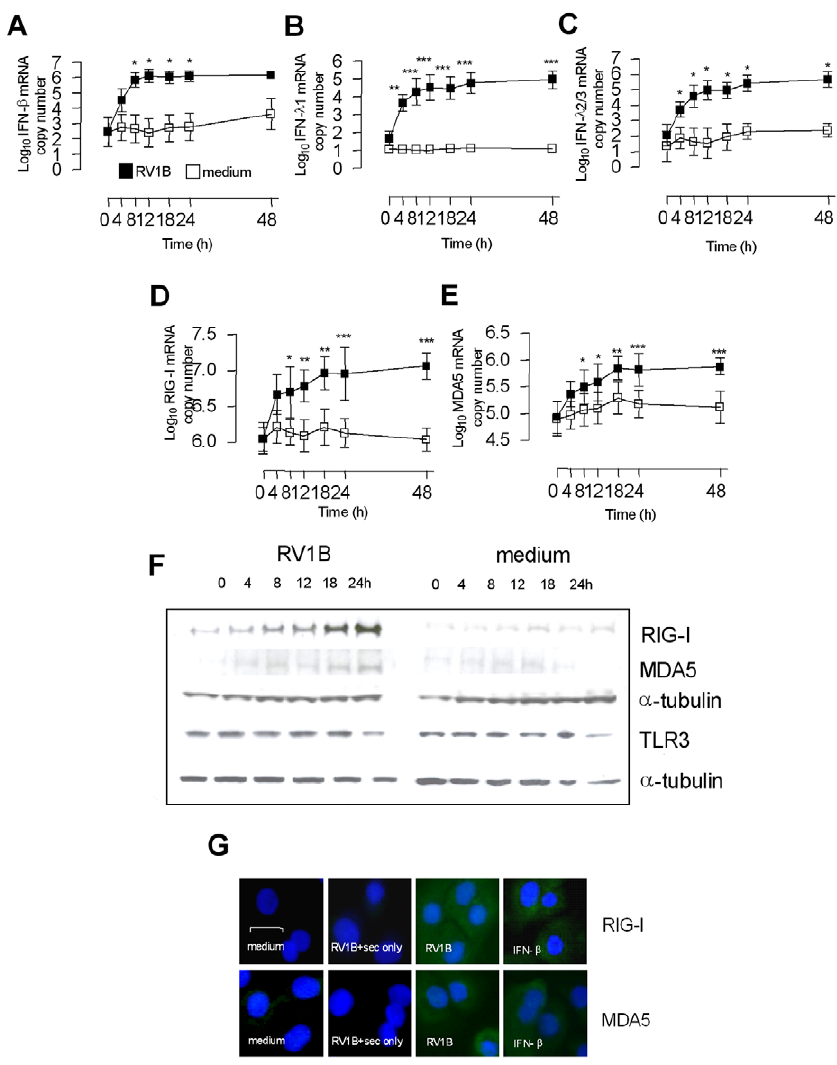
Figure 1. Kinetics of RV1B induced IFN- b , IFN- l s, RIG-I and MDA5 mRNA and protein expression in HBECs. HBECs were infected with RV1B or treated with medium and RNA and protein analysed over time. RV1B induced IFN- b (A), IFN- l 1 (B) and IFN- l 2/3 mRNA (C) in a time dependent manner, visible by 4 h, and peaking at 12–48 h. RV1B infection also induced RIG-I (D) and MDA5 mRNA (E), in a time dependent manner, peaking at 18–48 h. RV1B infection also induced RIG-I and MDA5 protein (F) in a similar time dependent manner, visible by 8 h post infection by western blotting. Medium treated cells exhibited little or no RIG-I or MDA5 protein during the timecourse. TLR3 protein levels were present in medium treated cells, and did not change during the course of RV1B infection. Immunofluorescence identified both cytoplasmic RIG-I and MDA5 to be induced after RV1B or IFN- b treatment at 24 h, compared to medium treated cells, or cells stained with secondary antibody only. Horizontal line indicates 20 m m scale. Staining for both helicases was observed within the cytoplasm (in green, G). * p , 0.05, ** p , 0.01, *** p , 0.001, RV1B infected versus medium treated cells. mRNA data was generated from 6 independent experiments utilizing 3 independent HBEC donors, 2 experiments per